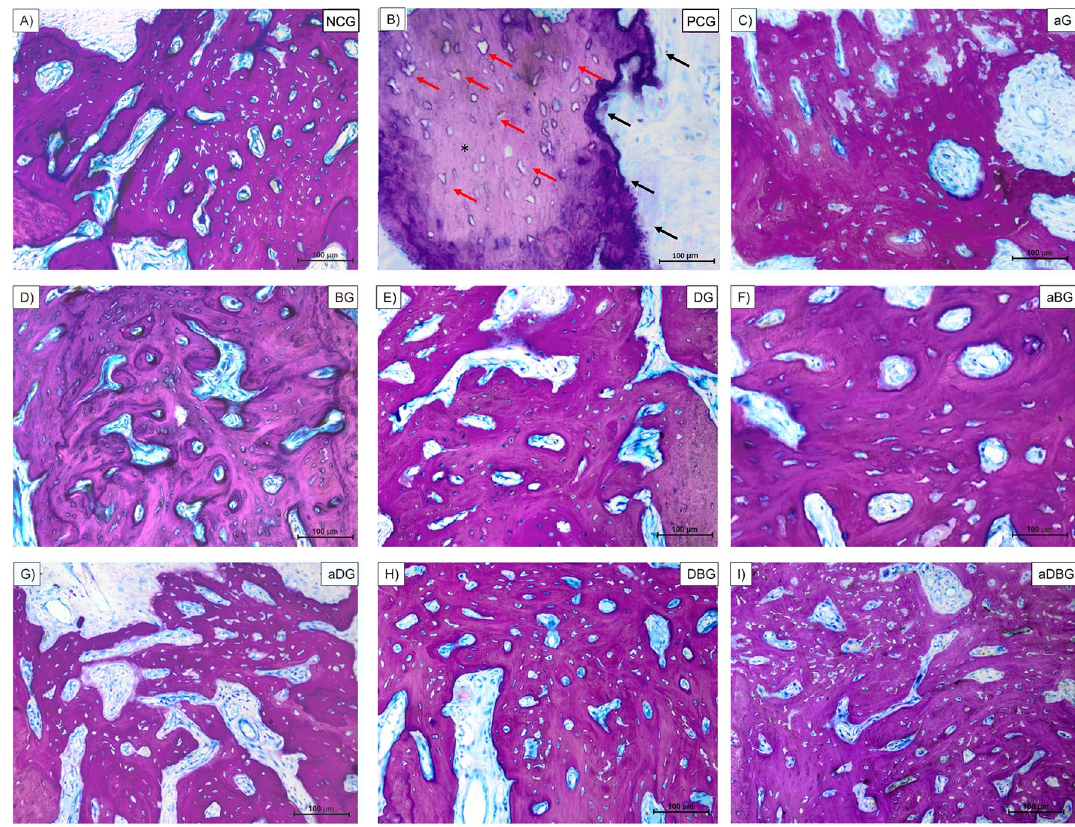
Figure 7. Representative photomicrographs of the sections stained in Stevenel’s blue and acidic fuchsin at 40 × magnification (blue, connective tissue; pink, mineralized tissue). Image ( A ) represents the NCG group, ( B ) PCG, ( C ) aG, ( D ) BG, ( E ) DG, ( F ) aBG, ( G ) aDG, ( H ) DBG, and ( I ) aDBG. (*, bone fragment in the middle of connective tissue; red arrows, empty lacunae without osteocytes; black arrows, irregularities in bone